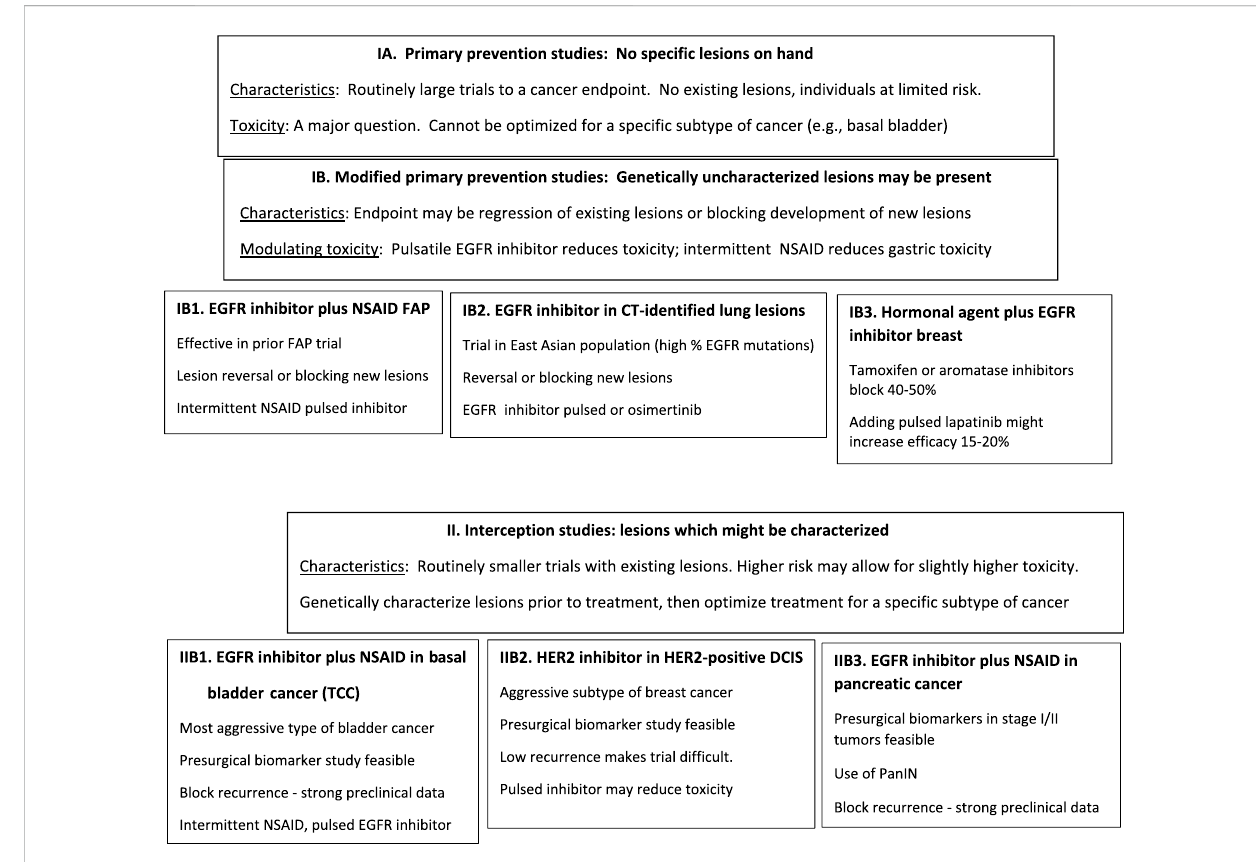
FIGURE 1 Examples of potential prevention and interception trials which include EGFR